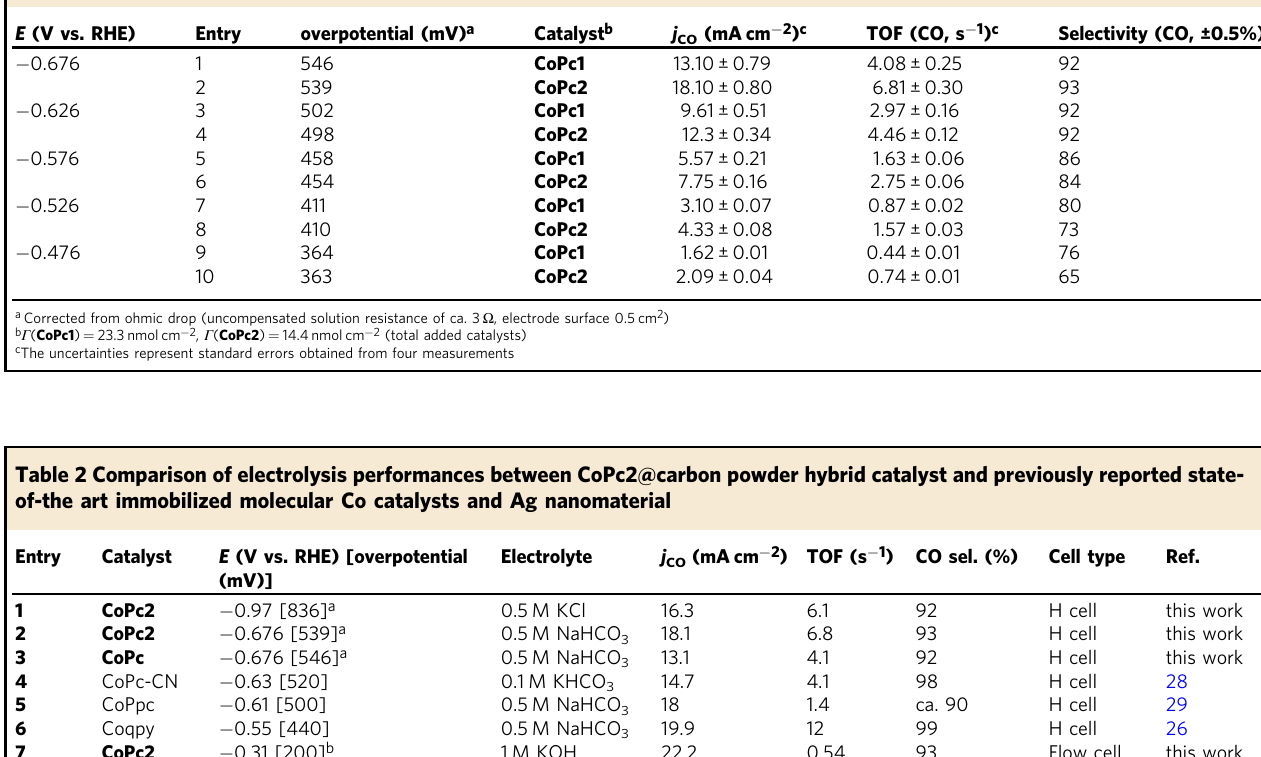
Table 1 Comparative data for CoPc1@MWCNTs and CoPc2@MWCNTs catalytic materials during a 1 h electrolysis as a function of the potential in CO 2 -saturated aqueous solution containing 0.5 M NaHCO 3 (pH 7.3) E (V vs. RHE)